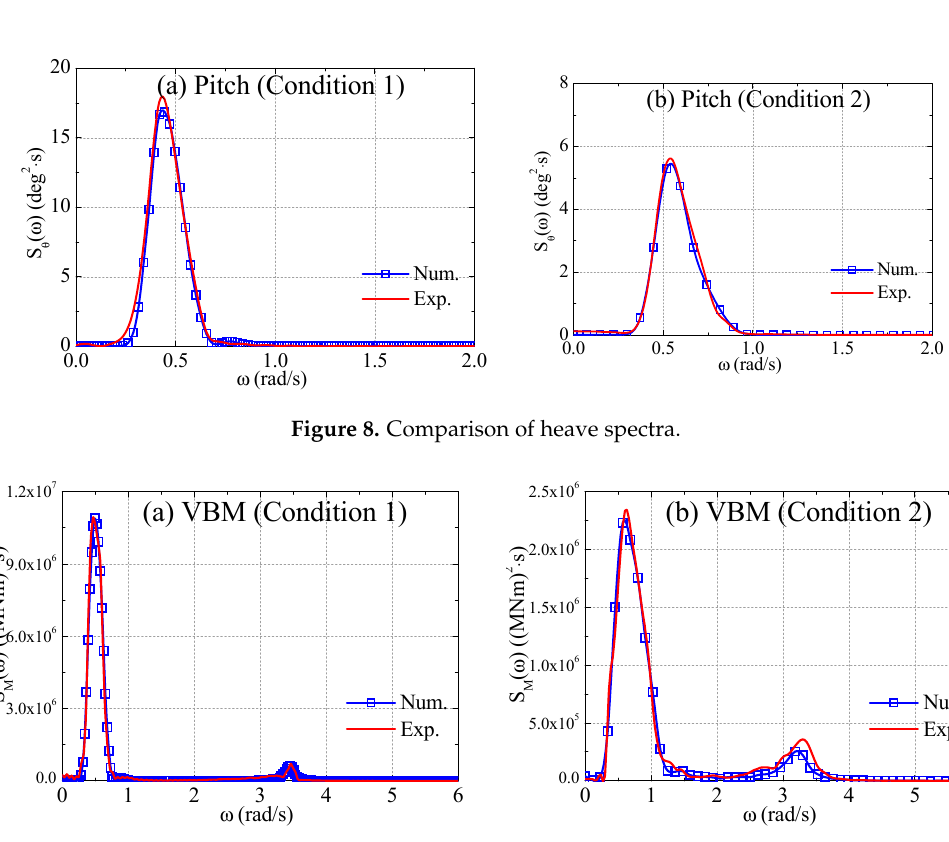
Figure 7. Comparison of heave spectra.